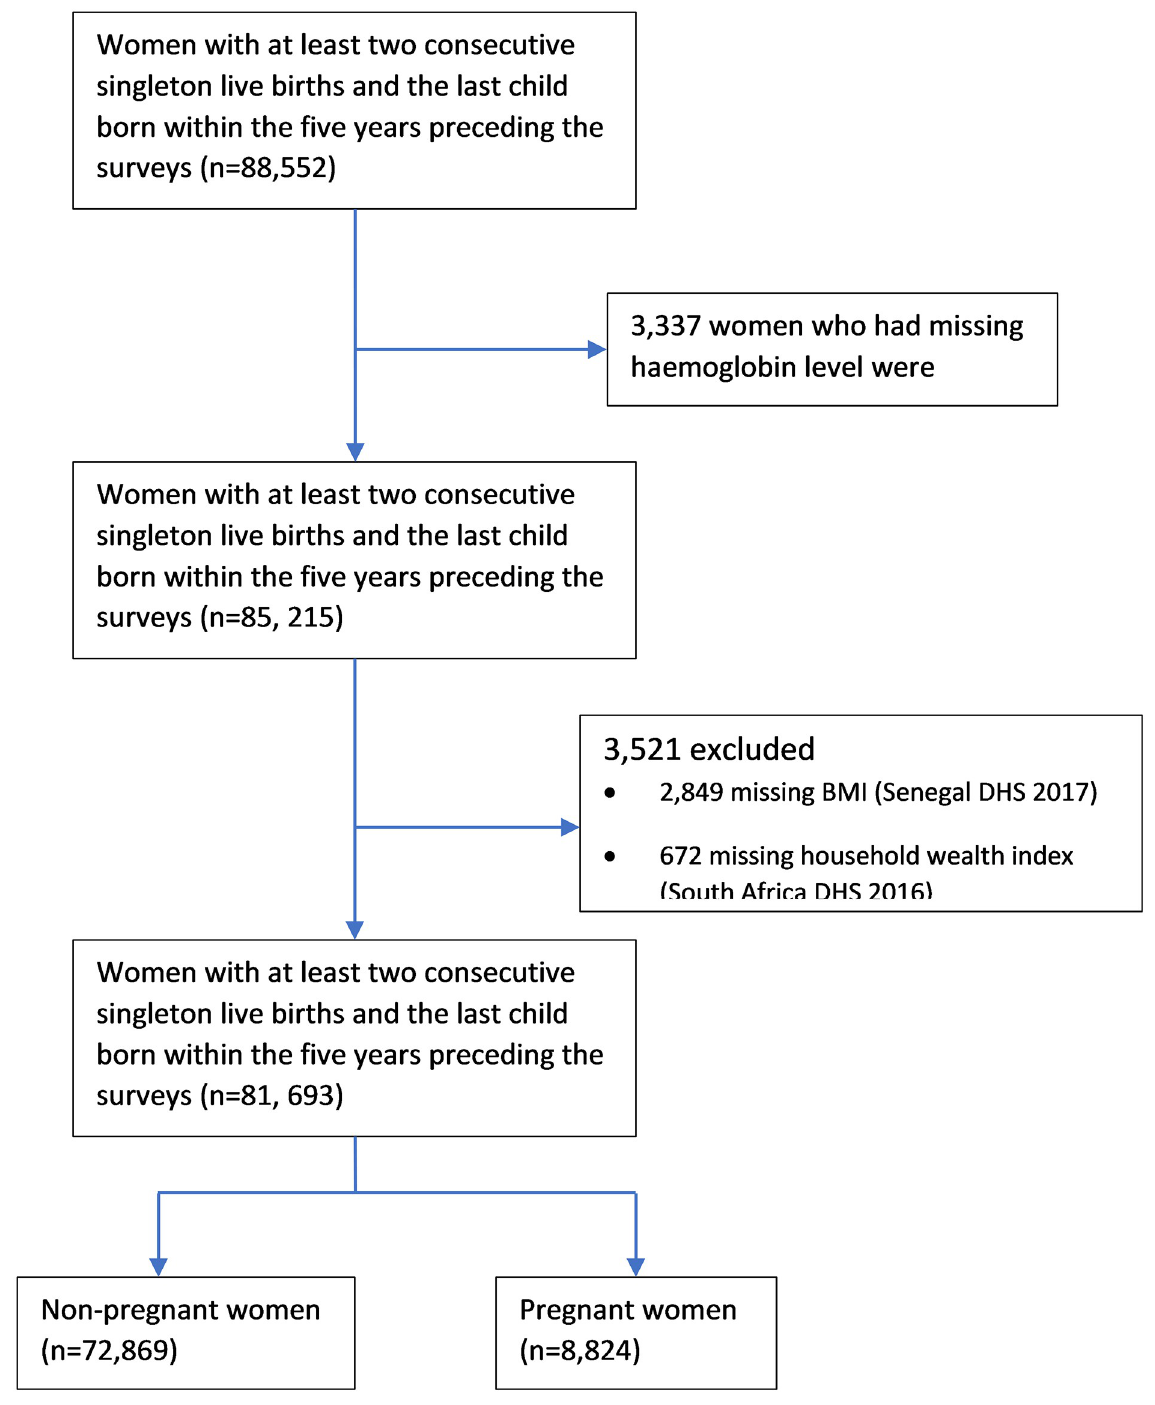
Fig 1. Flow chart of the analytic sample selection process.